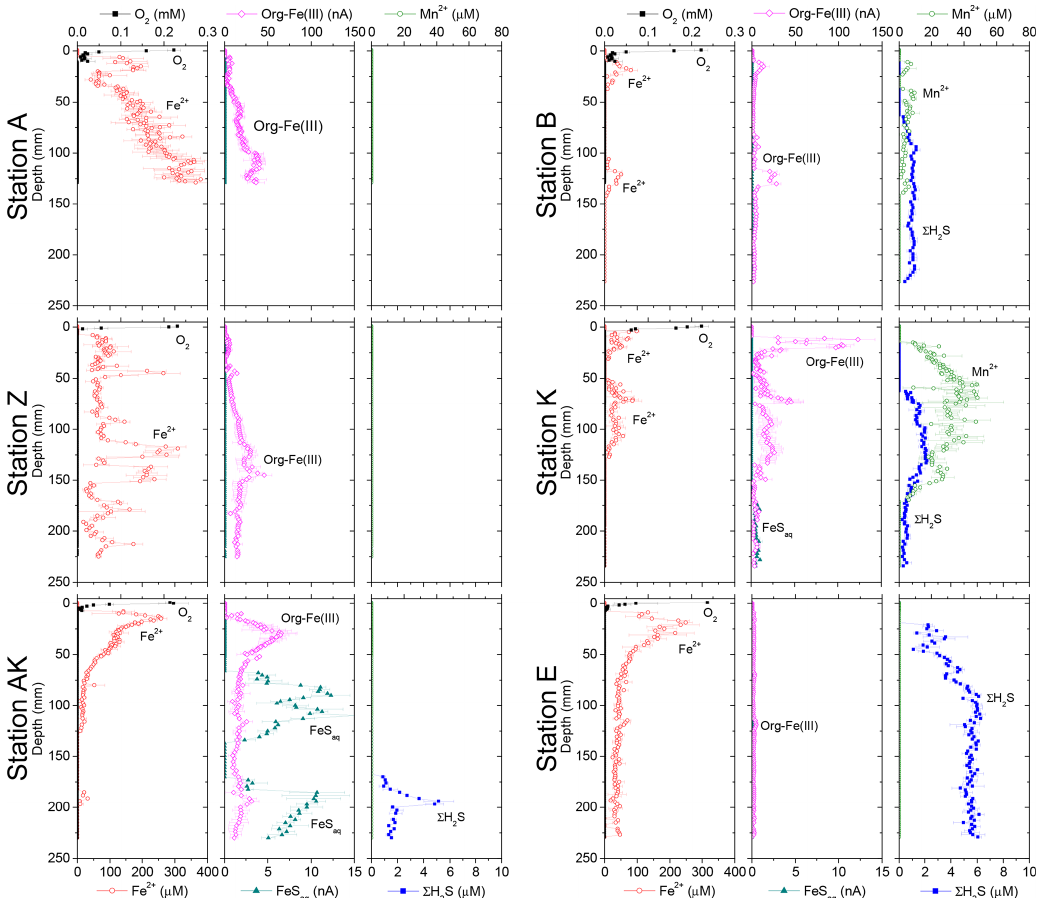
Figure 4. Depth profiles of dissolved O 2 , Mn 2 + , Fe 2 + , org-Fe(III), FeS aq and (cid:54) H 2 S concentrations measured electrochemically in intact sediment cores at stations A, Z, AK, K, B and E. Org-Fe(III) and FeS aq are reported in normalized current intensities